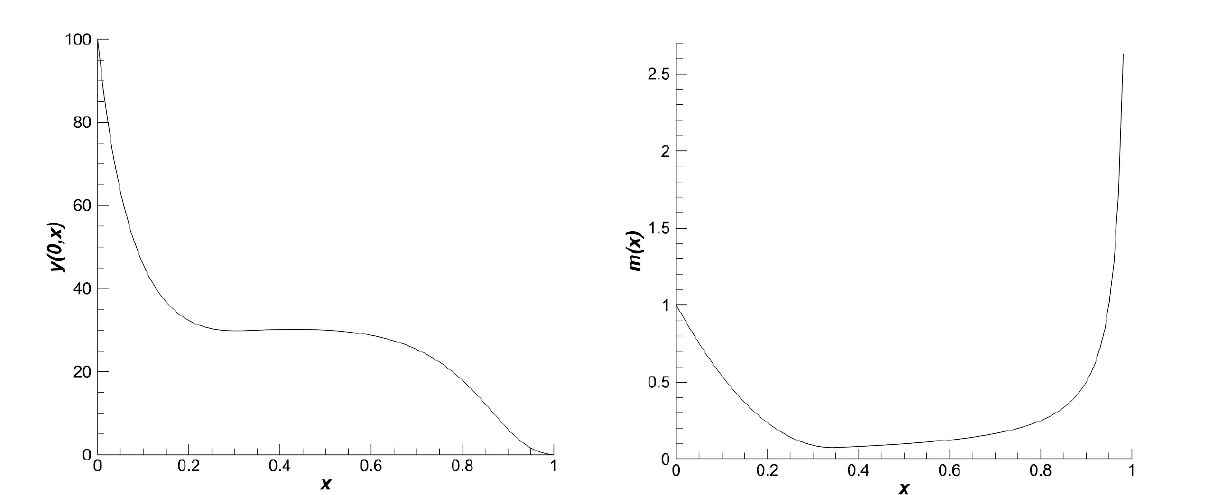
Figure 1. The postulated population density y ( 0, x ) in equilibrium ( left ) and the function m 1 ( x ) for natural mortality ( right ) vs. size x .